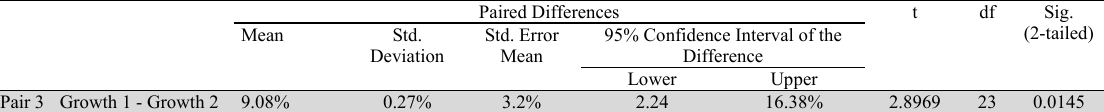
Paired sample T-test SMEs revenue growth